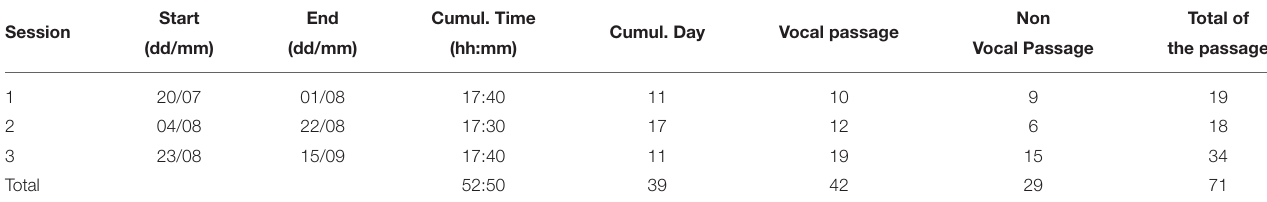
TABLE 2 | Summary of the records of all of the sessions and the number of passages for each session.